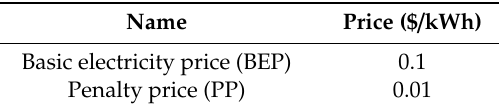
Table 3. Electricity price.